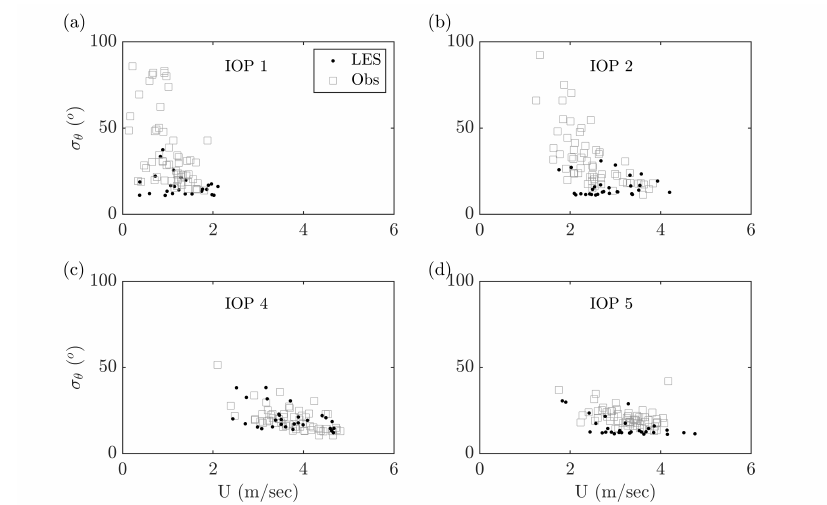
Figure 11. Comparison of wind direction standard deviation with wind speed during: ( a ) IOP1; ( b ) IOP2; ( c ) IOP4; and ( d ) IOP5. White boxes represent the observed values from GRI and COC towers during PSB1 and black dots represents the LES values.